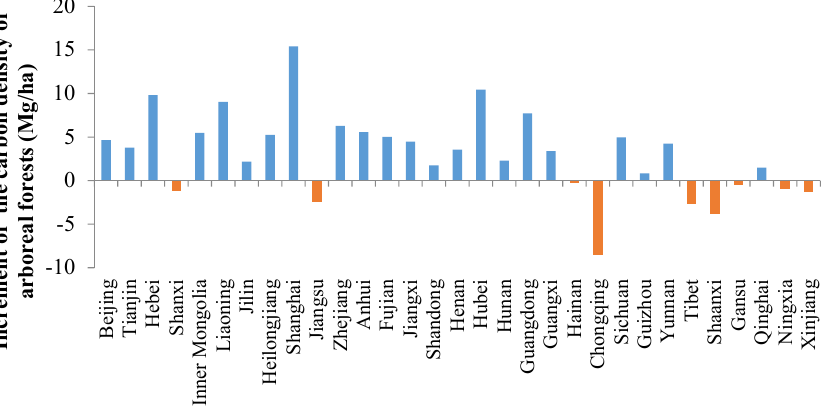
Figure 8. The variation of carbon density of arboreal forest in the provinces.